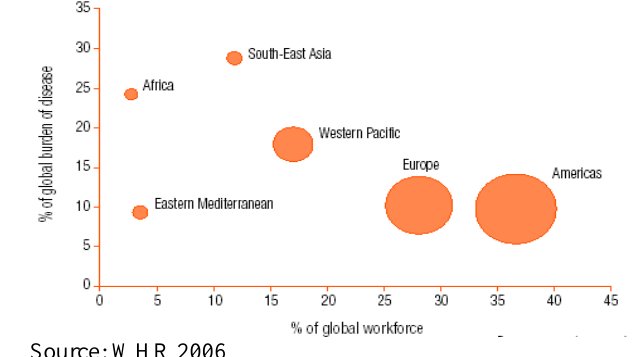
Figure 3: Distribution of health workers by burden of disease, by WHO region The urban-rural divide regarding HRH In general, amidst the inter-country and inter-regional imbalances in the density of the health workforce, there are also intra-country inequities, with greater numbers and better trained health workers concentrated in urban areas, to the detriment of rural areas (fig. 4).